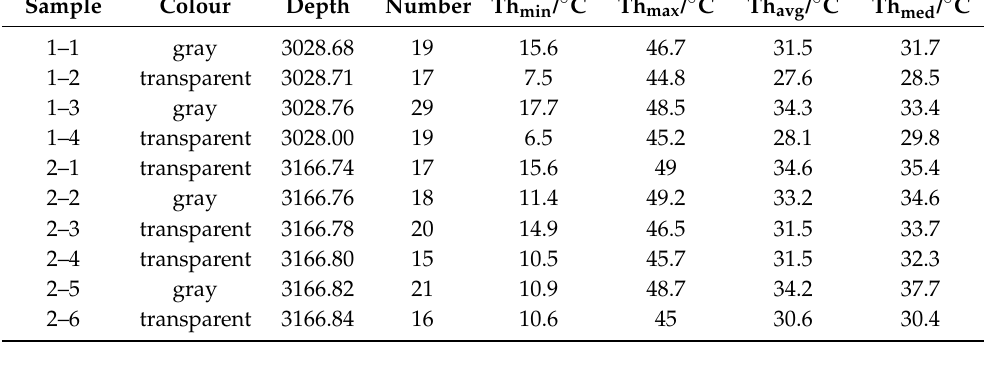
Table 2. Th data of halite inclusions of the studied core S1.